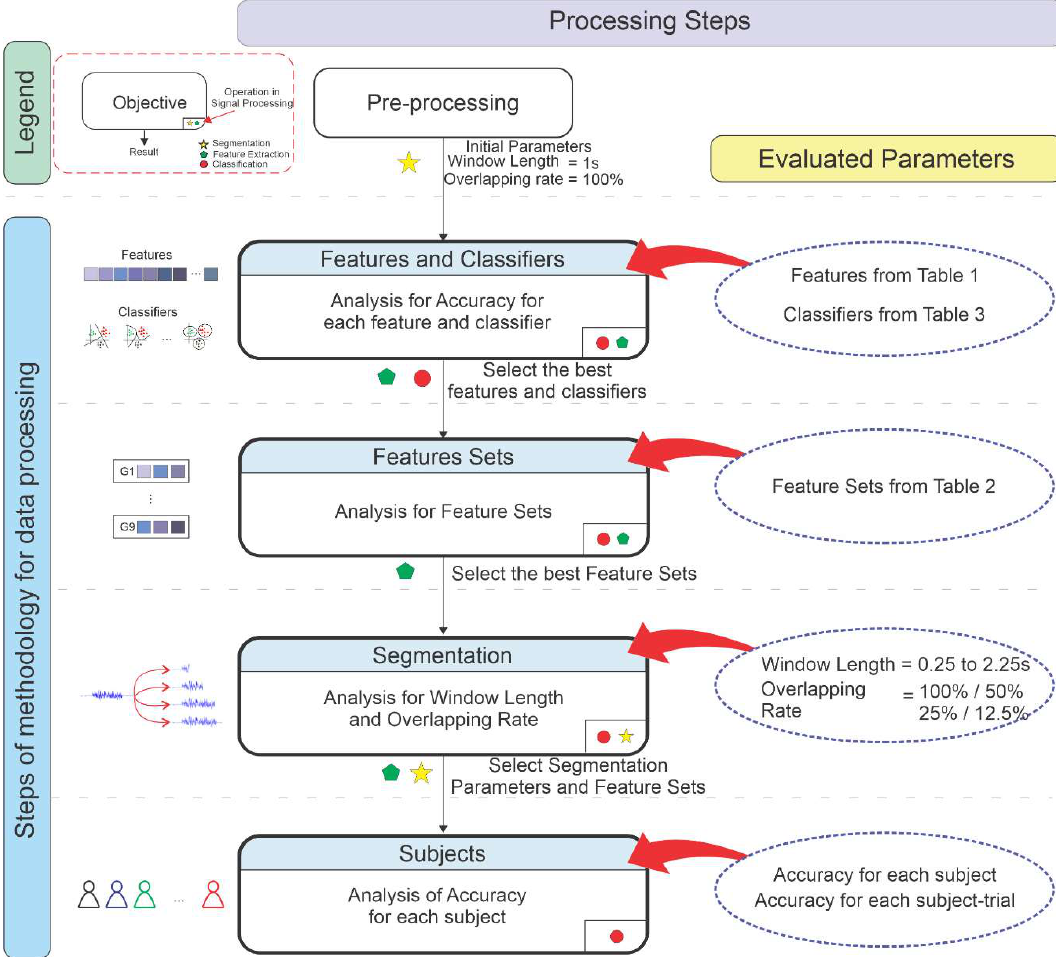
Figure 4. Steps in data processing methodology.